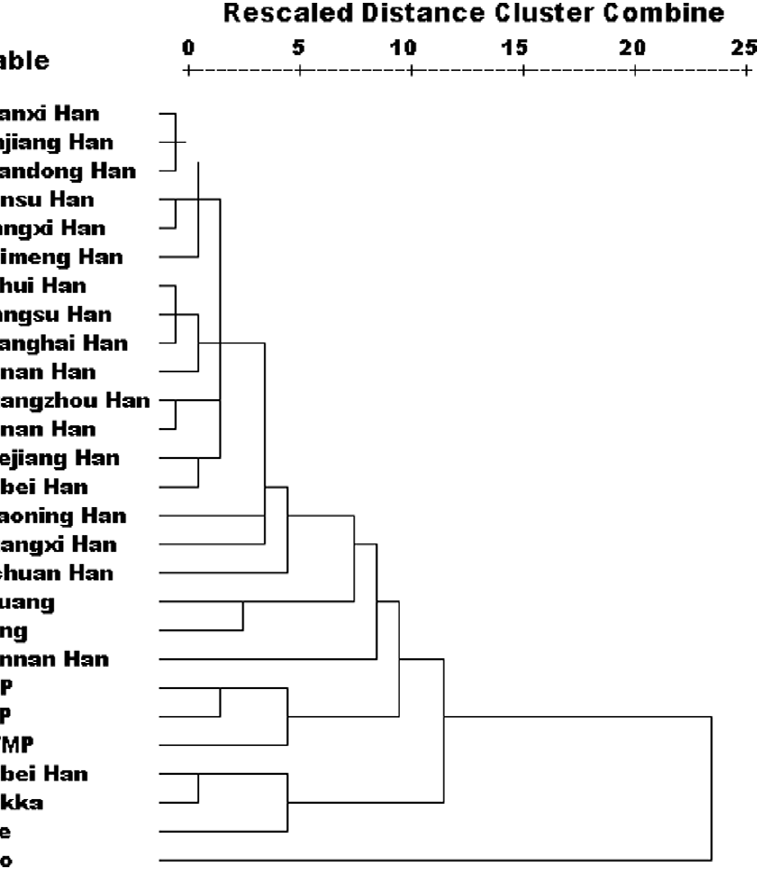
Figure 5. Dendrogram based on Y-SNP data. Shows the affinity between the three EC high-risk populations. Most Chinese Hans are grouped into a large cluster in the upper part of the dendrogram.